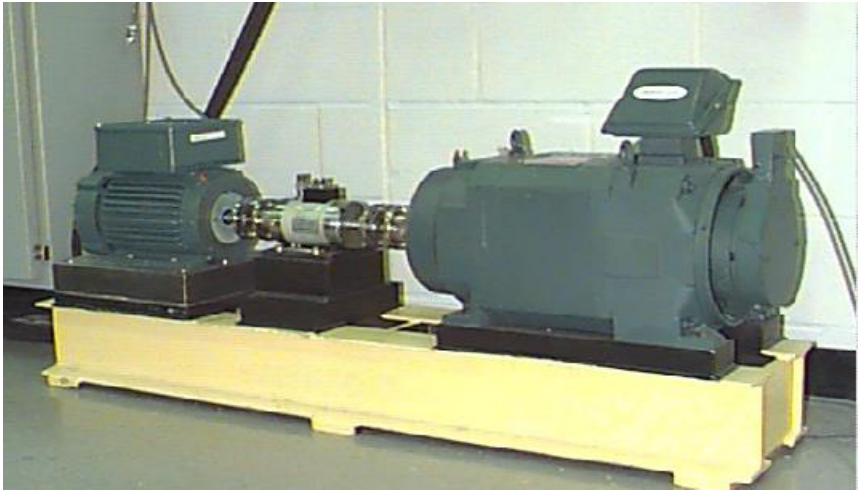
Figure 3. The rolling bearing fault